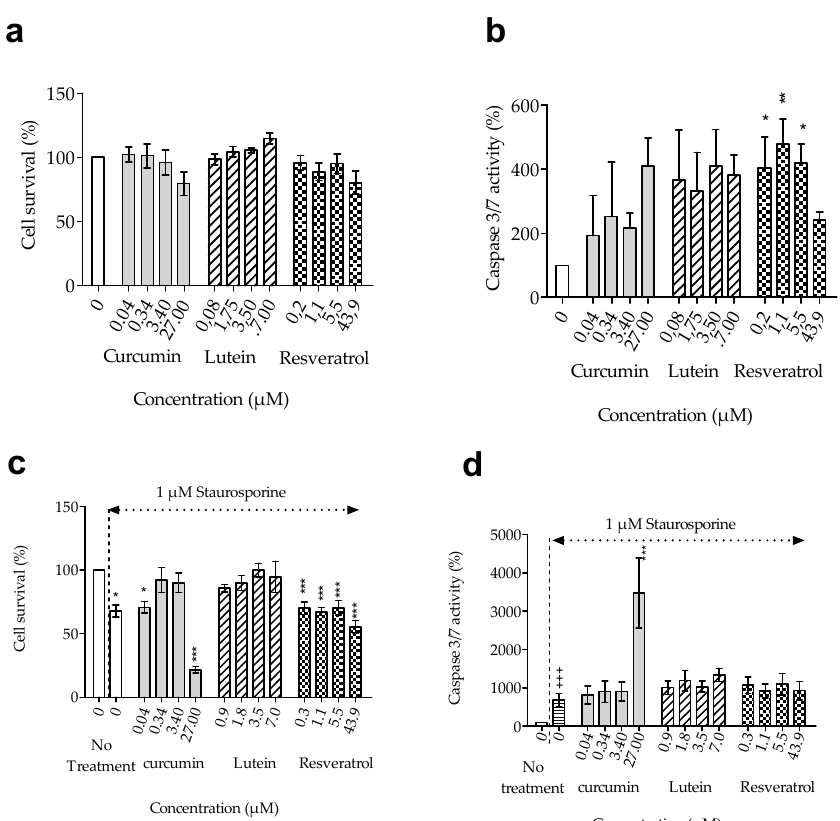
Figure 6. E ff ect of curcumin, lutein, and resveratrol on cell survival and caspase activity. ( a ) Cell survival and ( b ) caspase activity in ARPE-19 cells pre-treated for 24 h with di ff erent concentrations of curcumin, lutein, or resveratrol. ( c ) Cell survival and ( d ) caspase activity in cells pretreated for 24 hours with di ff erent concentrations of curcumin, lutein, or resveratrol and then exposed to staurosporin at 1 µ M for 18 h. Results are expressed as mean % ± SEM ( n = 4–5 independent experiments). Statistical significance (*) compared to no pretreatment.